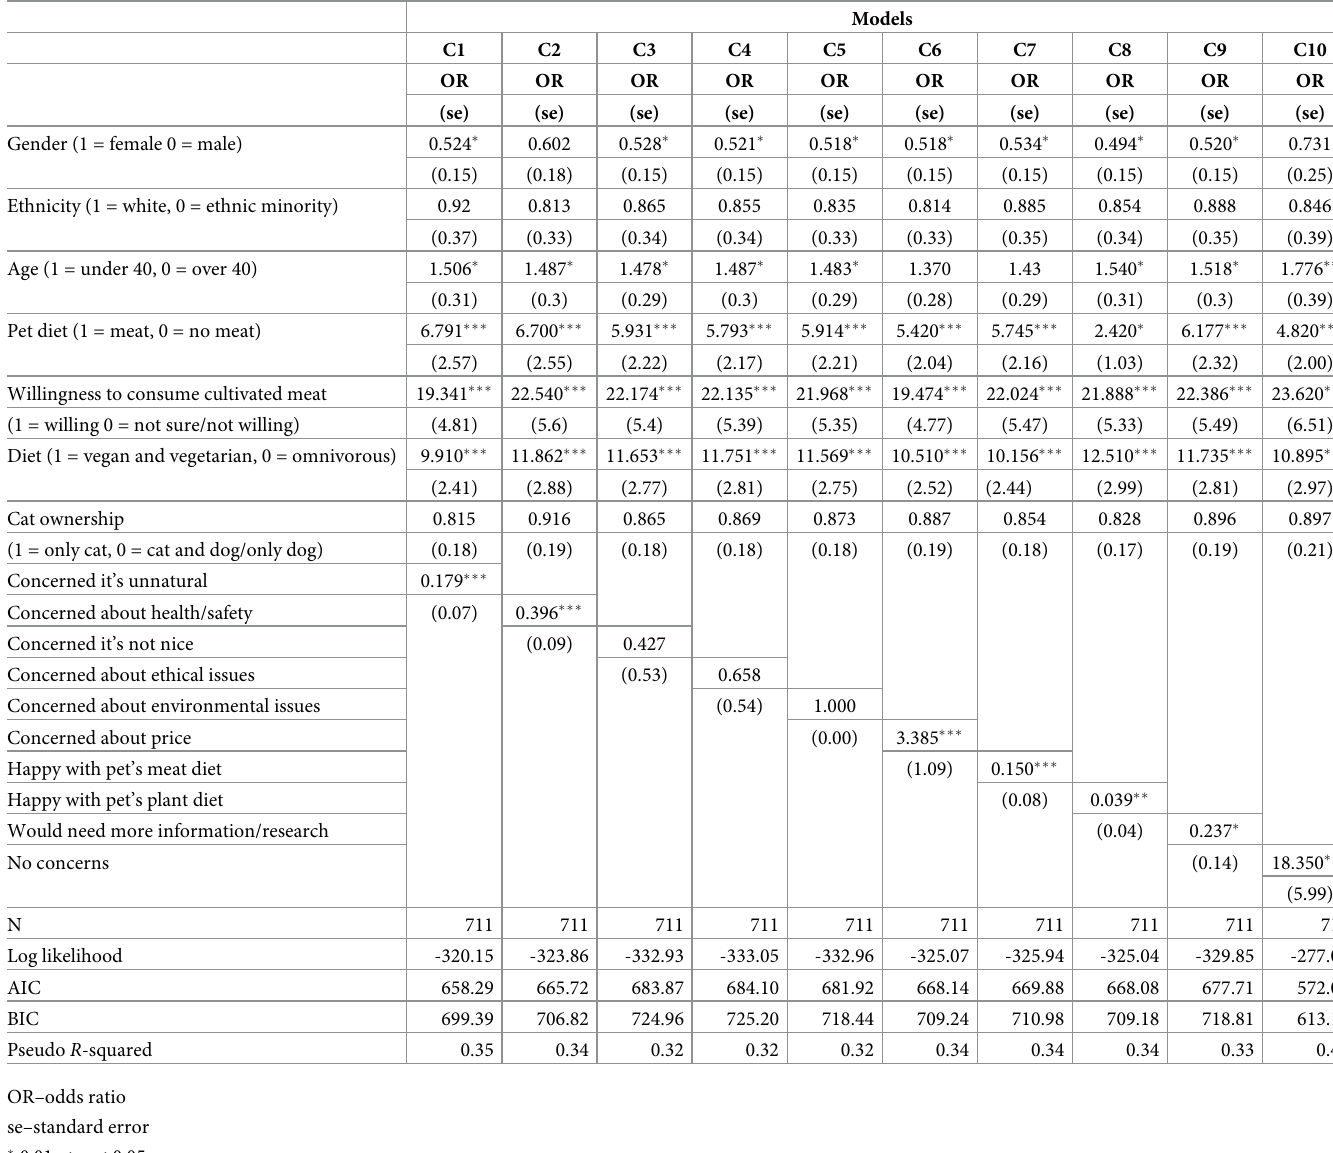
Table 11. Factors predicting the willingness to feed cultivated meat to pets–models including primary concerns about feeding cultivated meat to